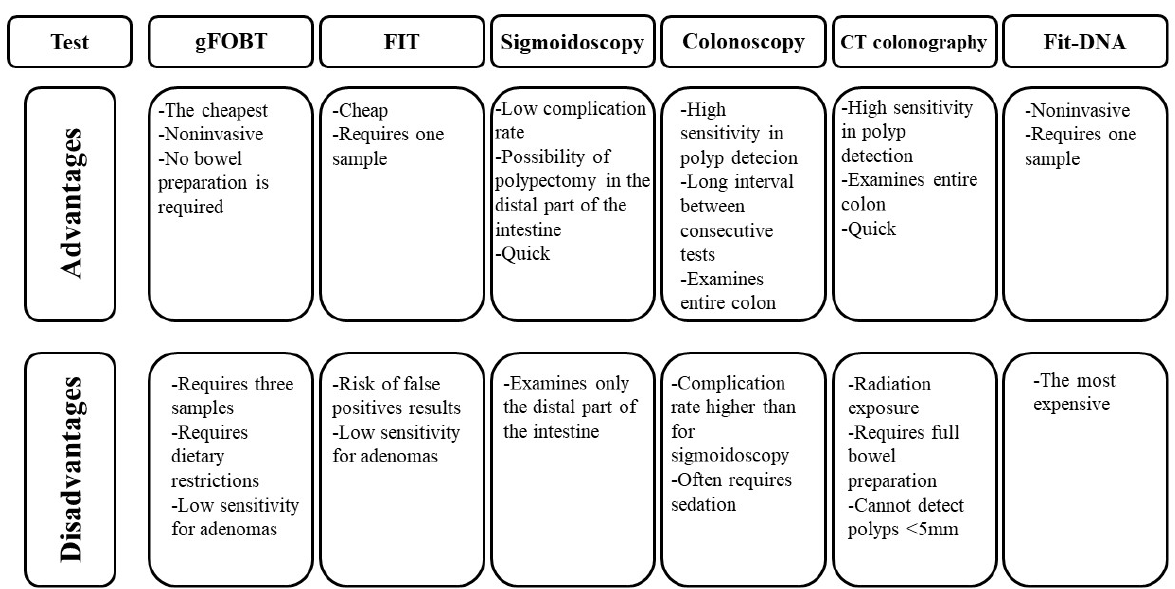
Figure 1. Advantages and disadvantages of selected screening tools in the diagnosis of CRC